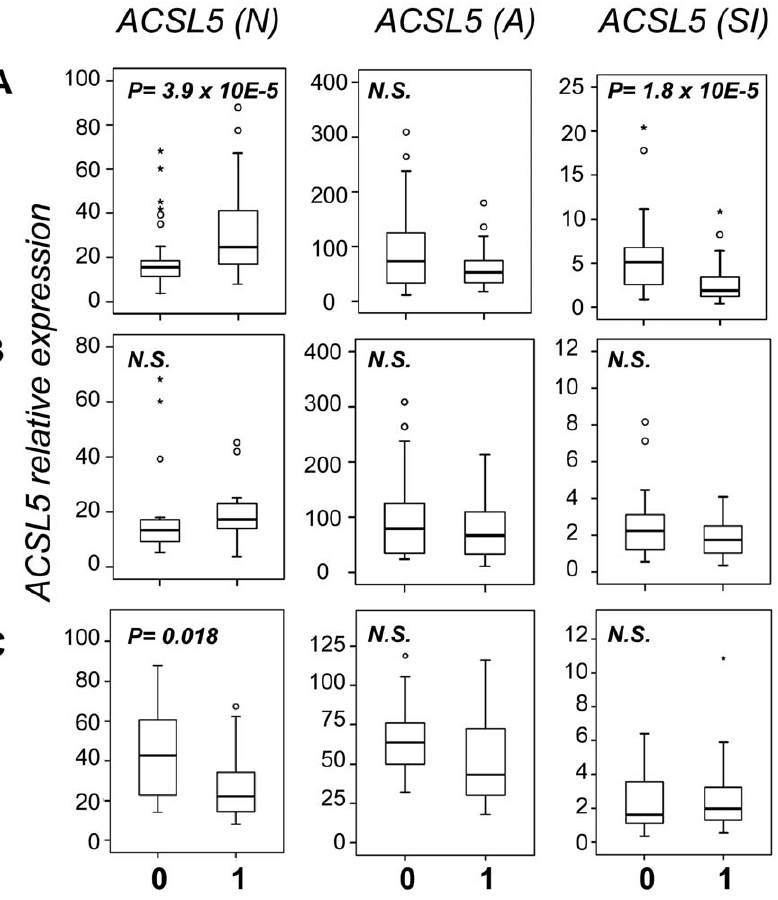
Figure 1. Association of ACSL5 mRNA expression levels with SLE. A) ACSL5 transcript levels in PBMCs from healthy controls (0) and SLE patients (1) for ACSL5(N) (number of samples n: 0=49, 1=45), activated ACSL5(A) (n, 0=34, 1=40) and the ratio A/N (ACSL5(SI) (n, 0=34, 1=40). B) ACSL5 transcript levels in PBMCs from males (0) (n=24) and females (1) (n=25), all of them from the control group. C) ACSL5 transcript levels in PBMCs from prednisone treated (1) (n=28) and untreated (0) (n=12) SLE patients. Results are represented in box plots given medians, quartiles, outsiders (circle points) and extremes (asterisk points). P-values of differences between the groups (0) and (1) are defined by Mann-Whitney Statistics. N.S . stands for non significant.